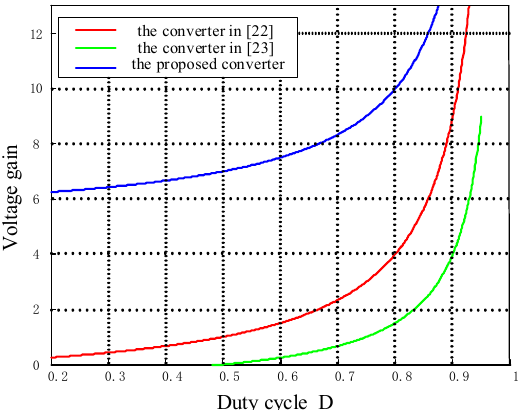
Figure 10. Comparison of voltage gain of converters.